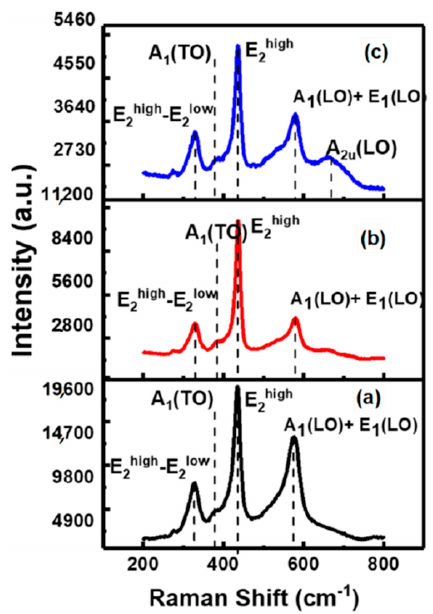
Figure 8. Raman spectra of ( a ) ZnO, ( b ) TZO1 and ( c ) TZO2. Reproduced with permission from Ref. [32]; published by Springer Nature, 2018.